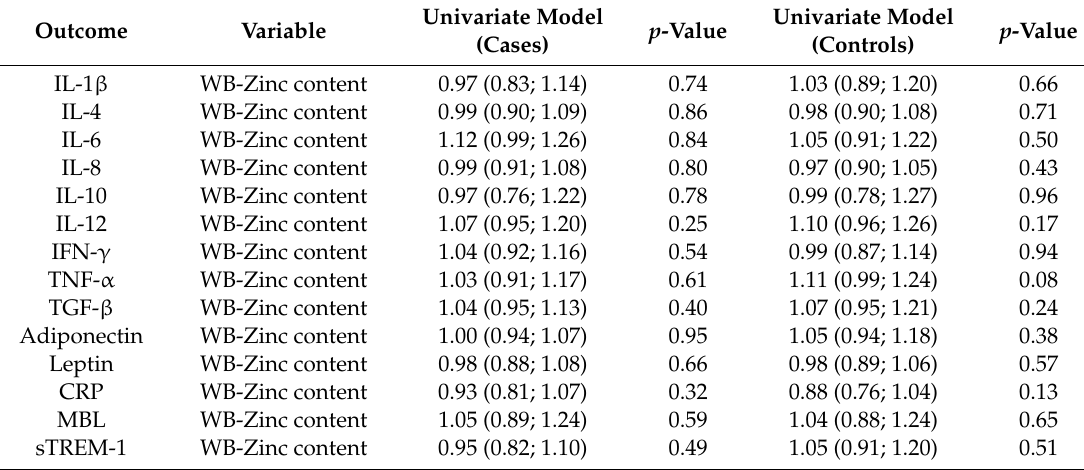
Table 3. Relative change in mean neonatal levels of cytokines, adipokines and other proteins involved in the immune response with a 95% confidence bands linked with every doubling in neonatal whole blood zinc content—results from univariate models with stratification by case status and no correction for multiple